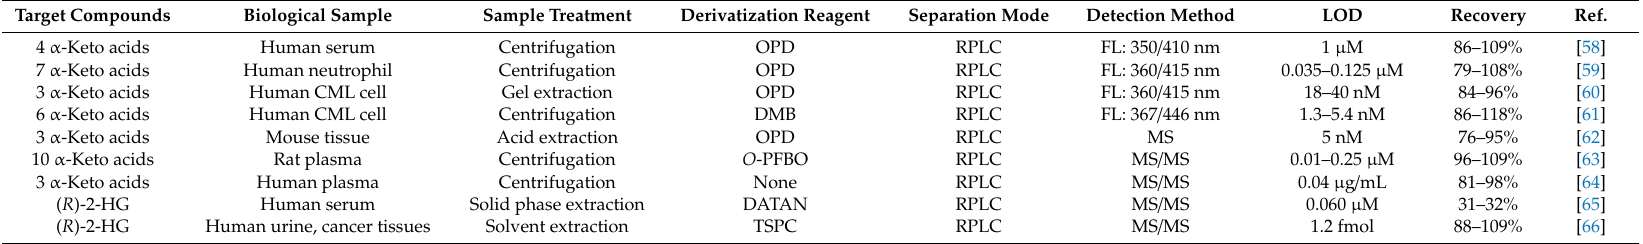
Table 5. Analytical methods for α -keto acids and 2-hydroxyglutaric acid (2-HG) in biological samples.